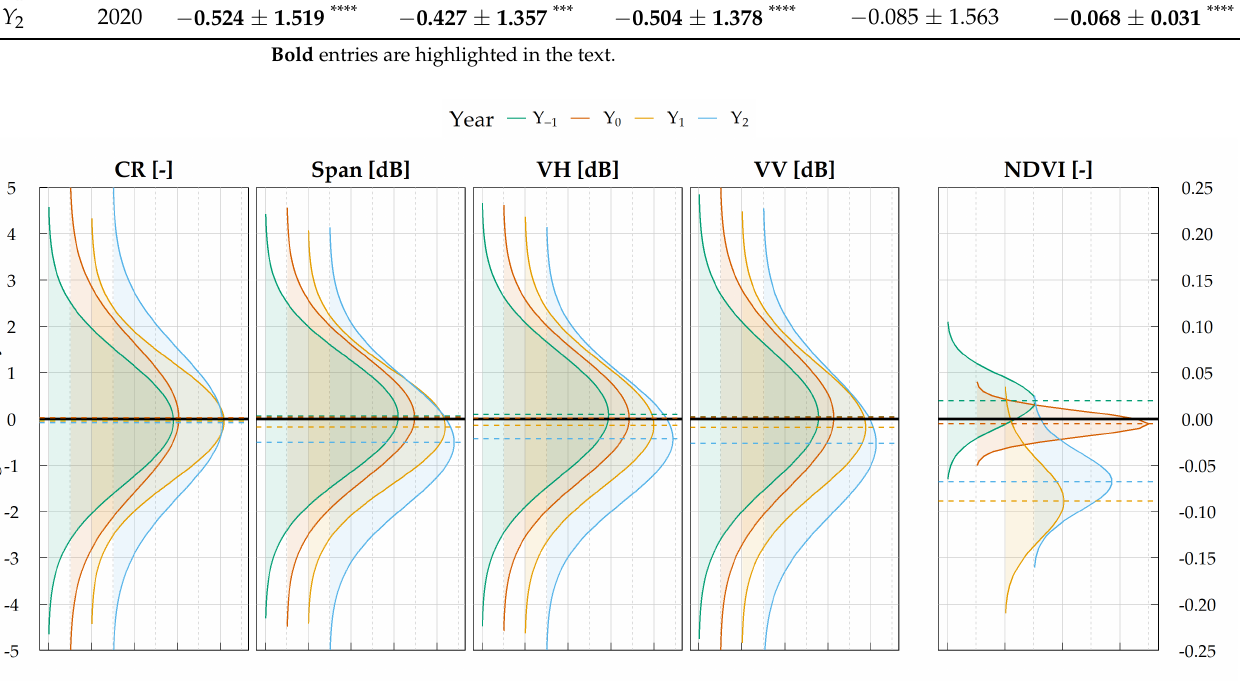
Figure 10. Signal anomaly between damaged (CD − ) and undamaged (CD0) trees for S-1 variables and S-2 NDVI. Probability density functions (pdf) were calculated based on mean and SD-growing seasonal differences. Metrics of the pdfs are declared in Table